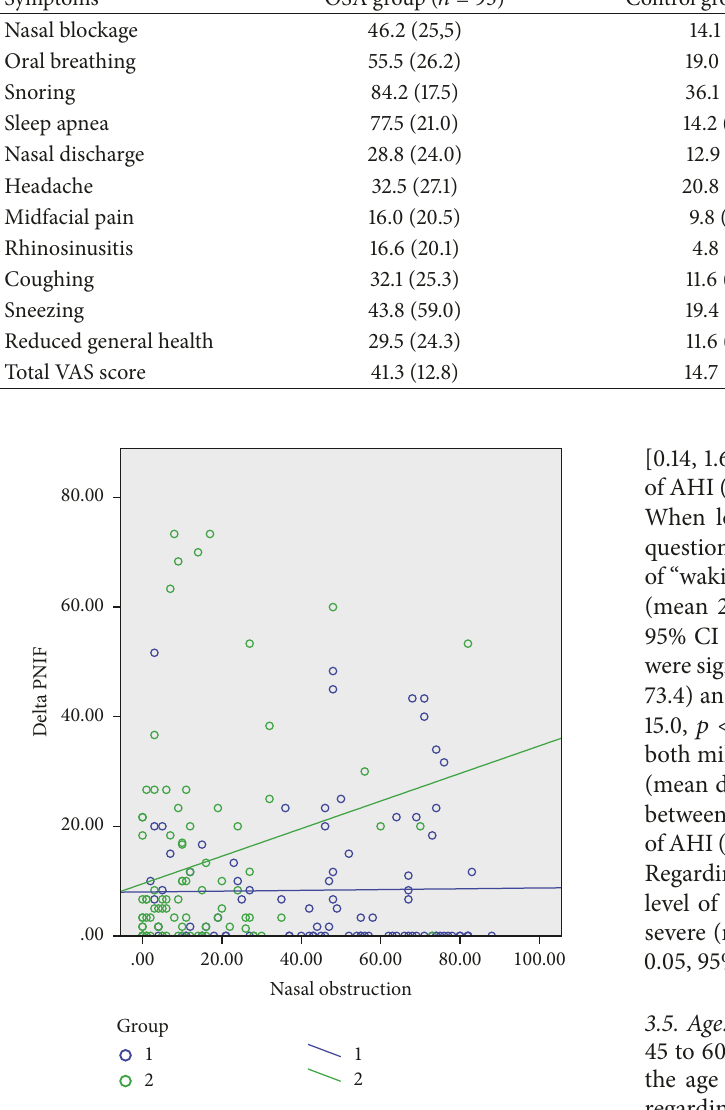
Figure 1: The change in PNIF before and after decongestion with xylometazoline compared to level of subjective nasal obstruction. Blue dots and line = OSA group. Green dots and line = controls. Delta PNIF = the absolute difference in PNIF at baseline and after decongestion (l/min). There is a significant positive correlation between VAS nasal obstruction and delta PNIF only in the control